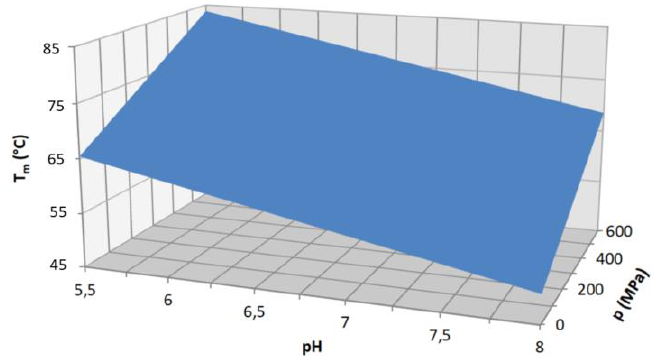
Figure 4. Three-dimensional multivariate fit of the transition temperature vs. pH and pressure, in case of the HepB1 oligo measured by Somkuti et al. [14]